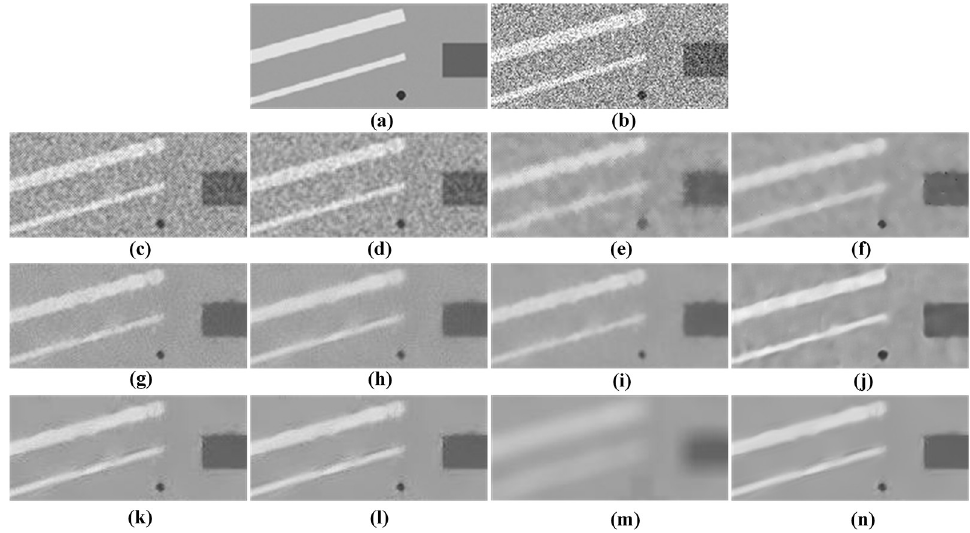
Fig 6. Comparison of zoomed details in Fig 5 for the twelve despeckling methods. (a) Original ROI, (b) Noisy ROI, (c) Frost filter, (d) Kuan filter, (e) SBF filter, (f) SRAD filter, (g) TNLM filter, (h) OBNLM filter, (i) NLMLS filter, (j) DnCNN filter, (k) OPCA-NLM filter, (l) RPCA-NLM filter, (m) SPCA-NLM filter, and (n) PPCA-NLM filter.